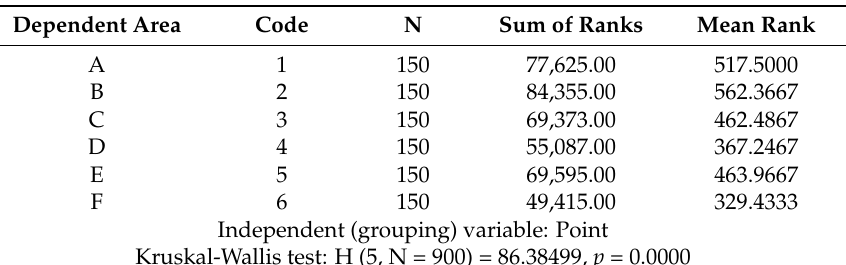
Table 5. Kruskal-Wallis test for area variable.